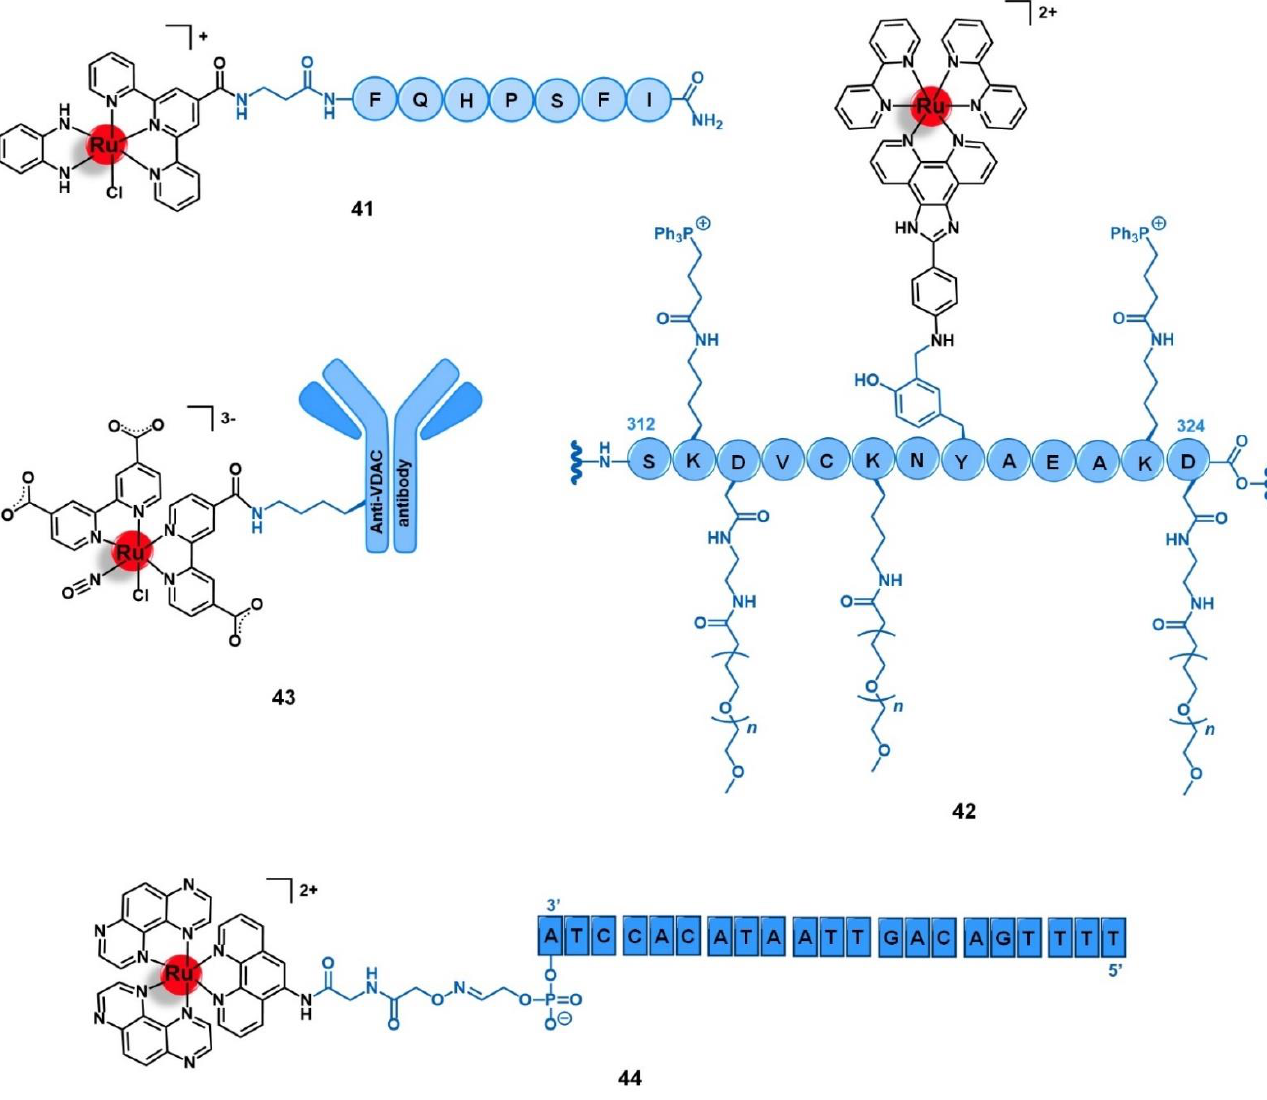
Figure 14. Ru(II) and Au(I) conjugates that target different organelles of cancer cells: 41 is specific for hepatoma cells membrane, 42 and 43 are specific of the mitochondria, and 44 to 46 include specific oligonucleotides for targeted delivery. Note that only a part of conjugate 42 is depicted (from amino acid 312 to 324 of the human serum albumin protein). VDAC = mitochondrial voltage-dependent anion-selective channels.